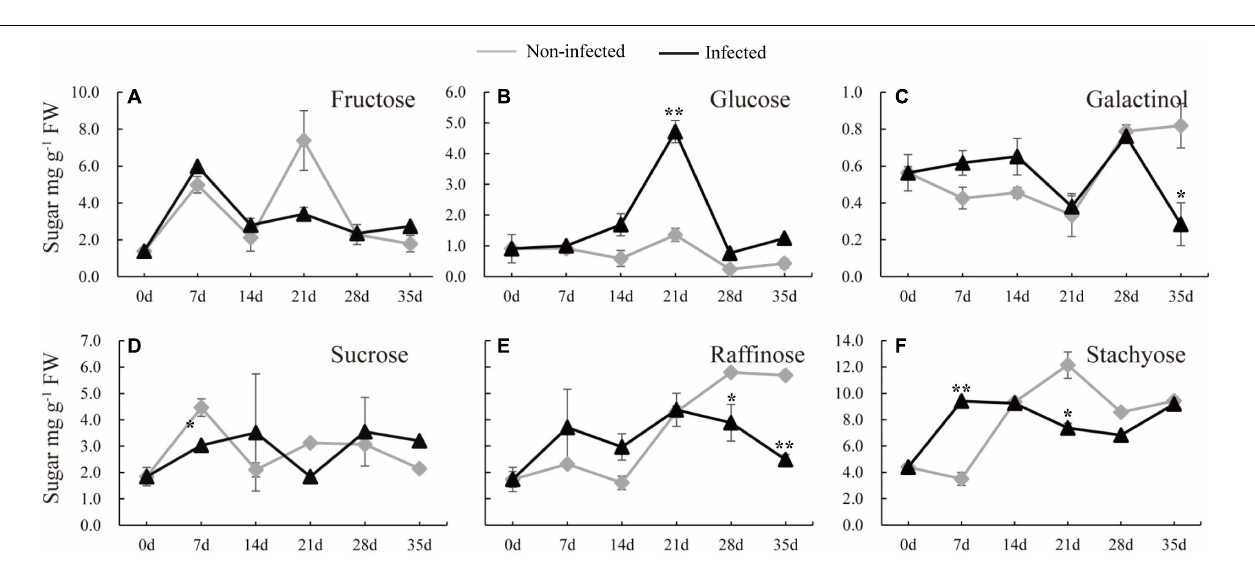
FIGURE 2 | Changes of carbohydrate content in infected and non-infected cucumber roots by M. incognita . (A–F) Are the content of fructose, glucose, galactinol, sucrose, raffinose and stachyose in cucumber roots, respectively. Error bars represent ± SE ( n = 6). Student’s t -test is analyzed between infected and non-infected roots, * P < 0.05; ** P <